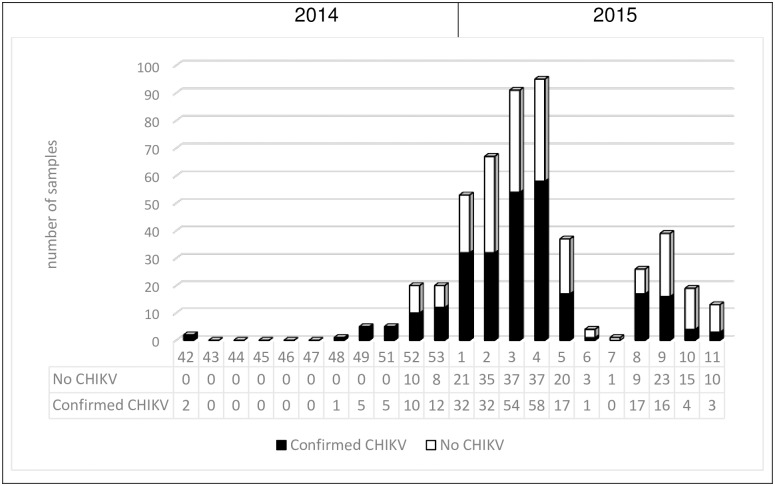
Number of samples collected for chikungunya diagnostics per epidemiological week, during the outbreak in Aruba from October 2014 –March 2015 (n = 498).Note: epiweek 6 and 7 coincided with Carnival, Aruba’s public holiday.